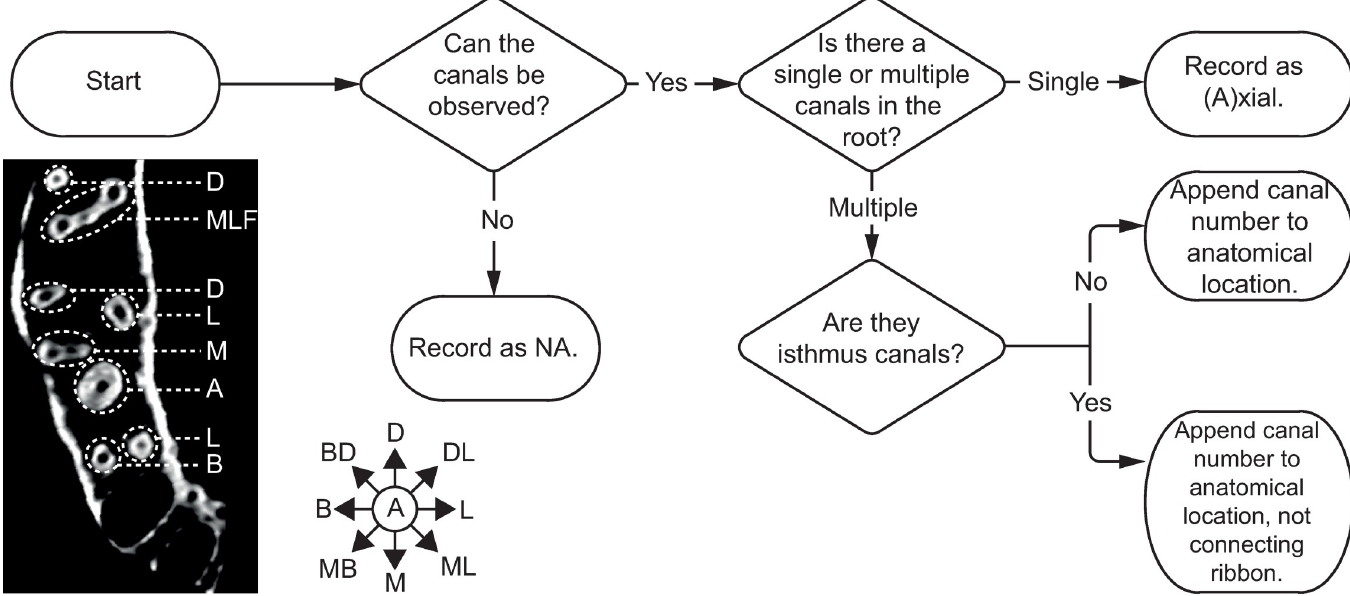
Fig 15. Flow chart for determining and recording phenotype element 3—anatomical location of canals. Bottom left: Axial CT scan slice of right maxillary dental arcade. Anatomical directions: A = axial, M = mesial, MB = mesio-buccal, B = buccal, BD = bucco-distal, D = distal, DL = disto-lingual, L = lingual, ML = mesio-lingual, F =